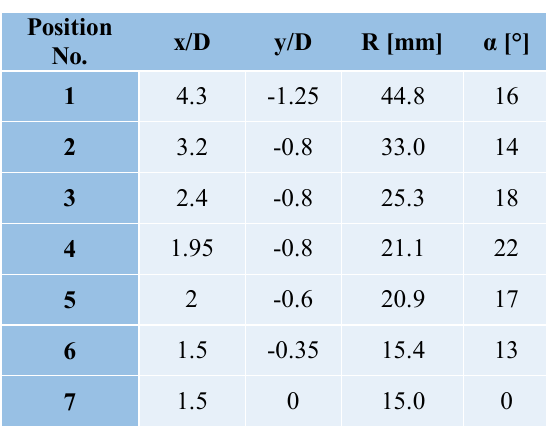
Table 1. Measured positions of the secondary